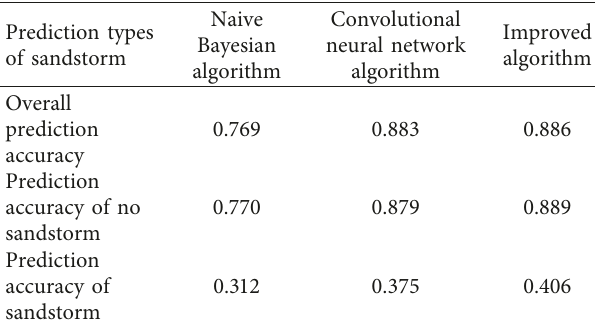
Table 8: Experimental